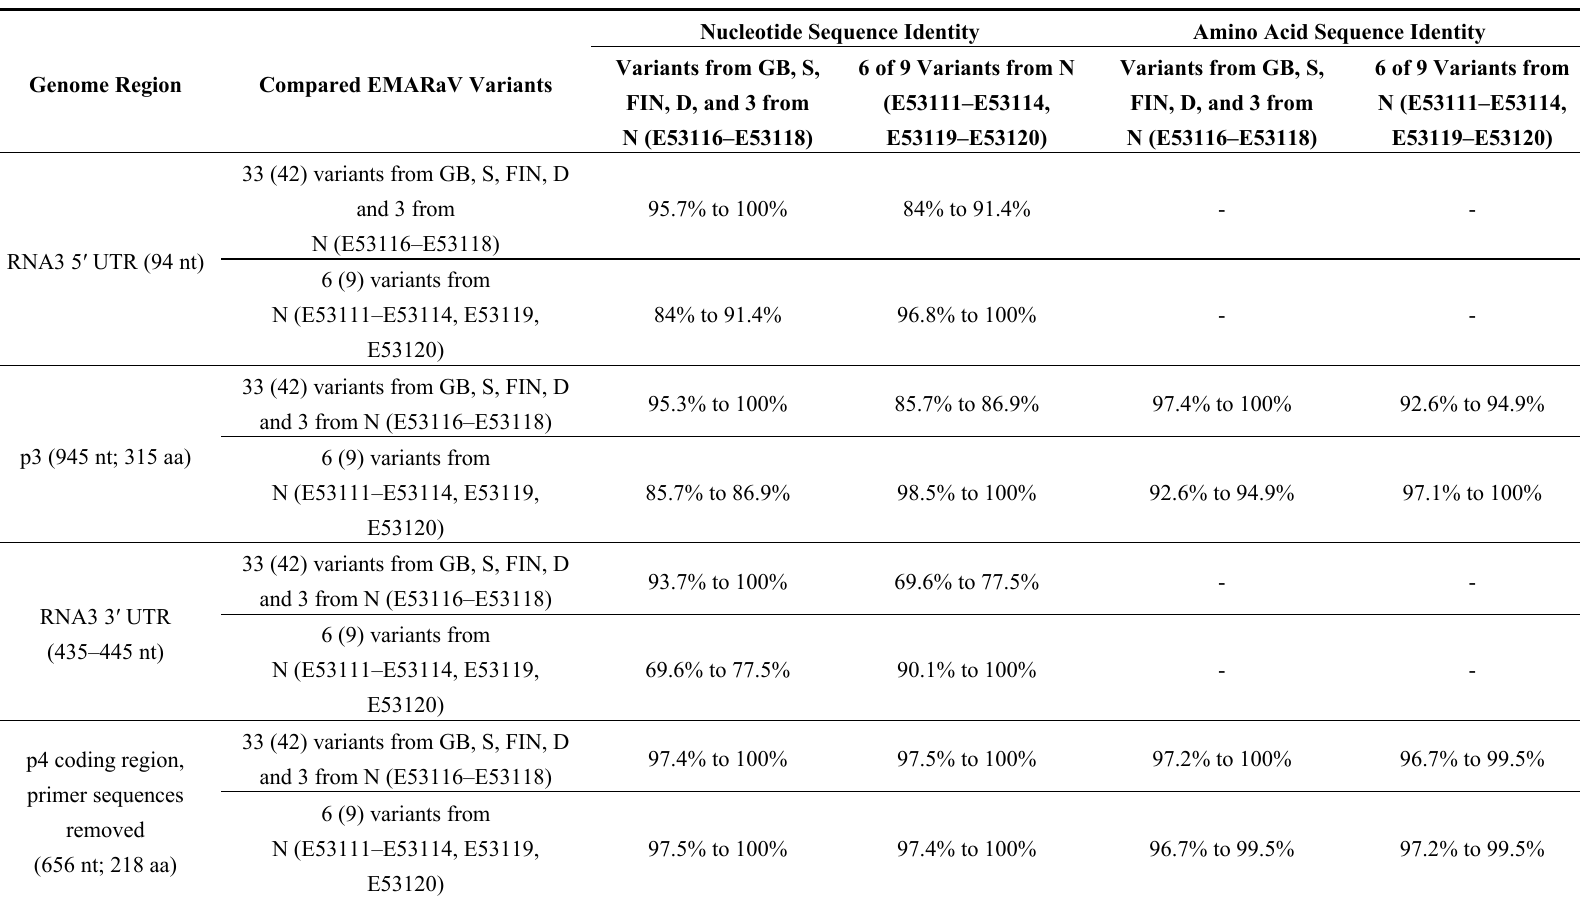
Table 2. Data compilation of sequence analyses using the similarity matrix with function IDENTIFY in BioEdit [32]. Nucleotide or amino acid sequences of two genome regions (RNA3 and p4 protein) of the different EMARaV variants were compared with each other and the values of the identity matrices were summarized (full tables can be found in the supplementary material). GB: Scotland, S: Sweden, FIN: Finland, D: Germany, N: